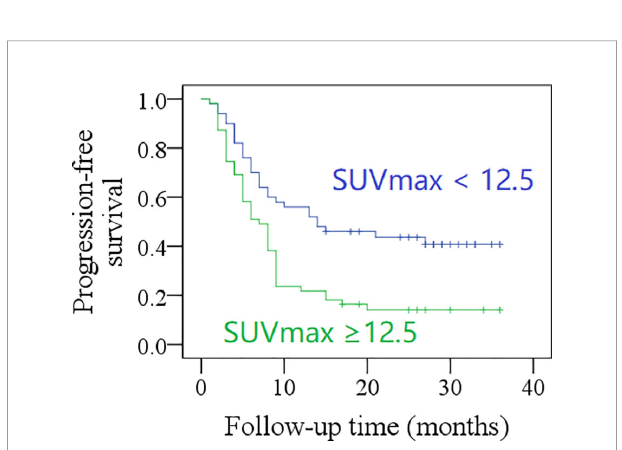
FIGURE 3 | Comparison of overall survival in patients with different total metabolic tumor volumes (MTV) ( p =